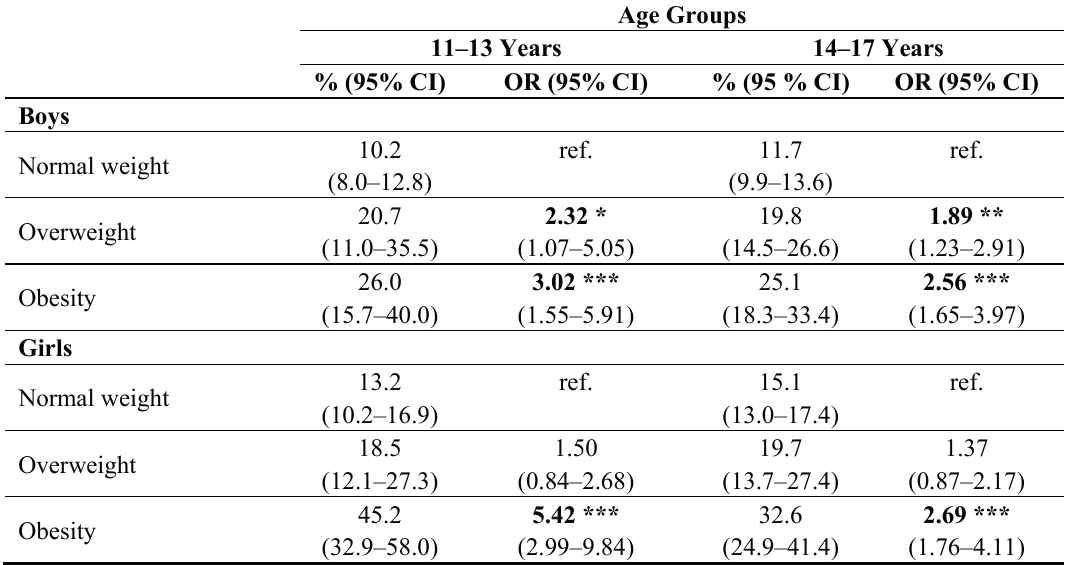
Table 2. Relation between BMI and SRH (fair to very poor) among adolescents aged 11 to 17 years stratified by age ( n = 4981). Prevalence and age-adjusted odds ratios (OR) with 95% confidence intervals (95%